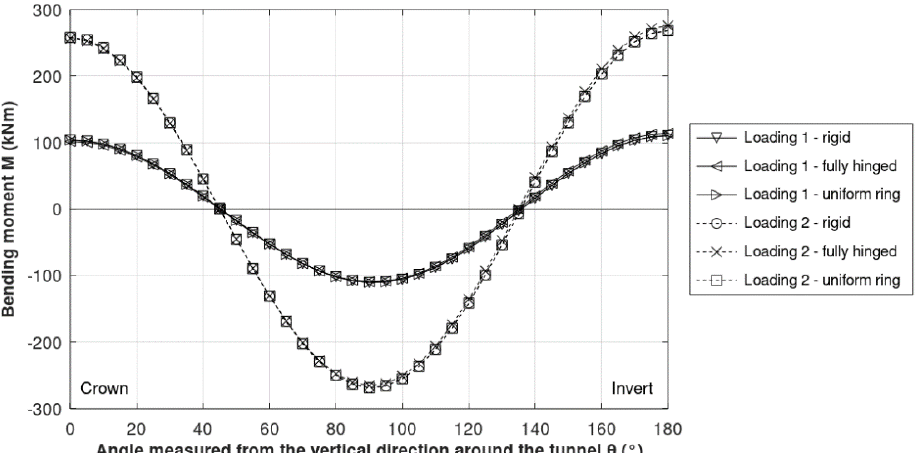
Fig. 9. Bending moments considering different joint configurations and loading conditions